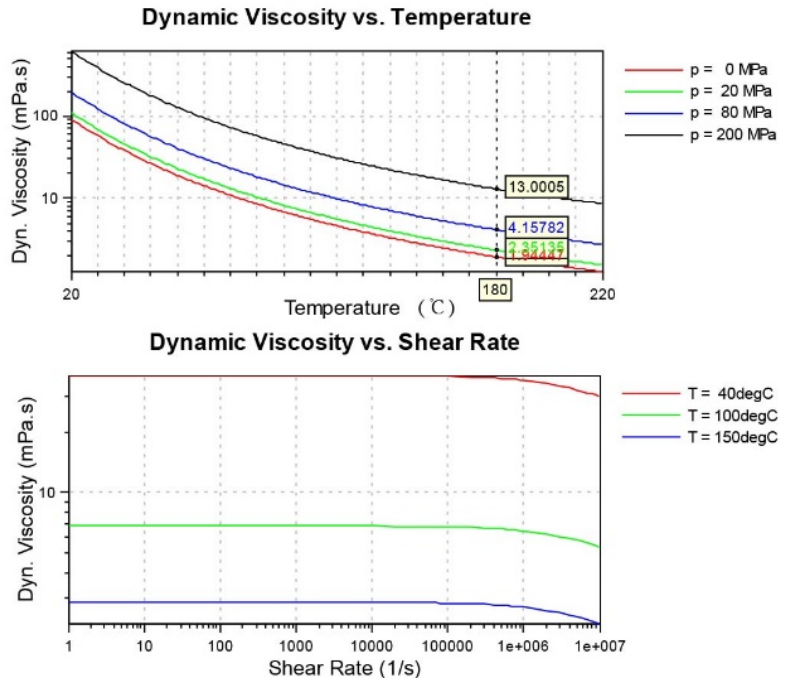
Figure 6. Viscous pressure and shear thinning effect of SAE 0W20 Standard Oil. The comparison of viscosity temperature relationship between SAE 15W40 and SAE 0W20 standard oil depicts in Figure 5, using data from the standard oil database in AVL Excite software.